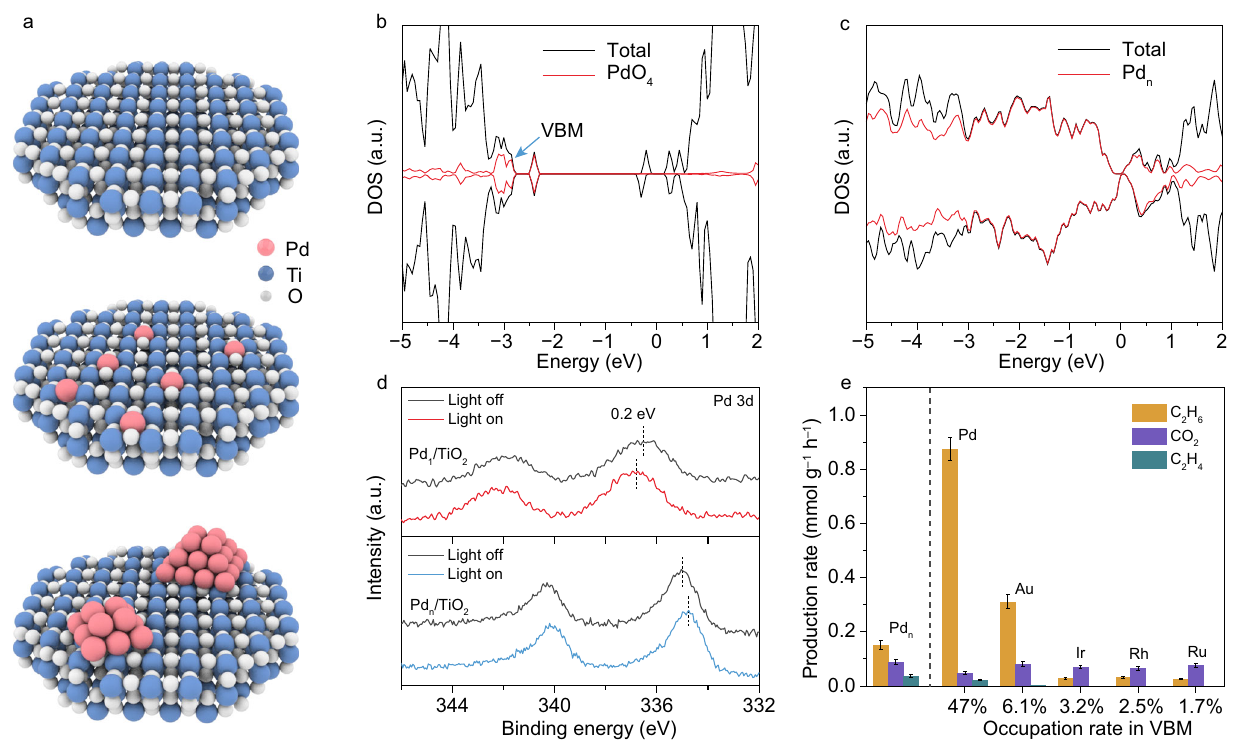
Fig. 1 Screening of metallic SAs with large contributions to VBM of M 1 /TiO 2 for photocatalytic NOCM. a Schematic illustration for TiO 2 (001)-based models — pristine TiO 2 (top), Pd 1 /TiO 2 (middle), and Pd n /TiO 2 (bottom). b , c Total density of states (TDOS) of Pd 1 /TiO 2 ( b ) and Pd n /TiO 2 ( c ). The red line represents the contribution of metals to TDOS, in which Pd – O 4 unit show the highest proportion in VBM (highlighted by blue arrow). d Pd 3d XPS spectra of Pd 1 /TiO 2 and Pd n /TiO 2 under light irradiation indicating charge accumulation. e The relationship of metal contribution in VBM and photocatalytic NOCM performance for various M 1 /TiO 2 as well as Pd n /TiO 2 . Reaction condition: 0.1 MPa CH 4 , 3 h light irradiation. The error bars represent the standard deviation of the